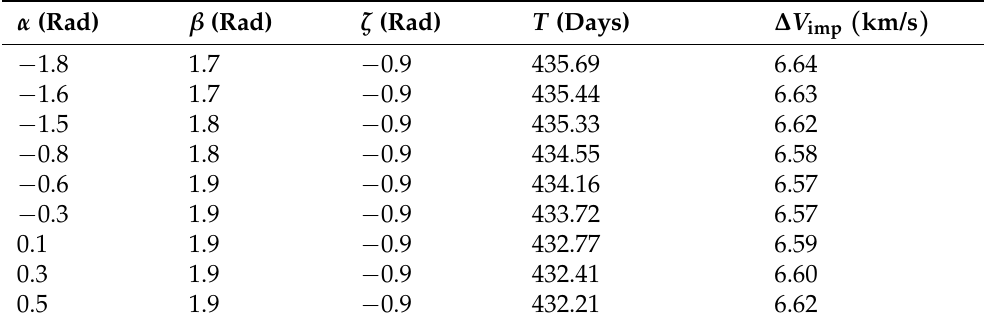
Table 2. Sample earth escape parameters and impact speeds (without using the NEXT-C